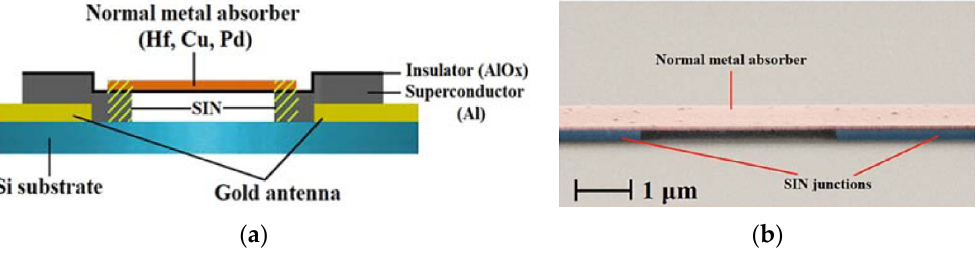
Figure 9. Schematic image ( a ) and photo ( b ) of SINIS detector with suspended absorber.